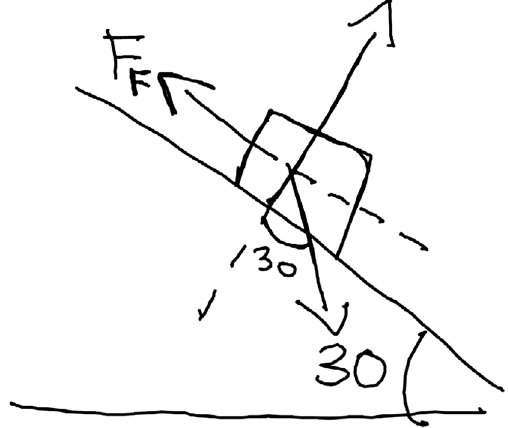
FIG. 7. Student B ’ s FBD for the friction